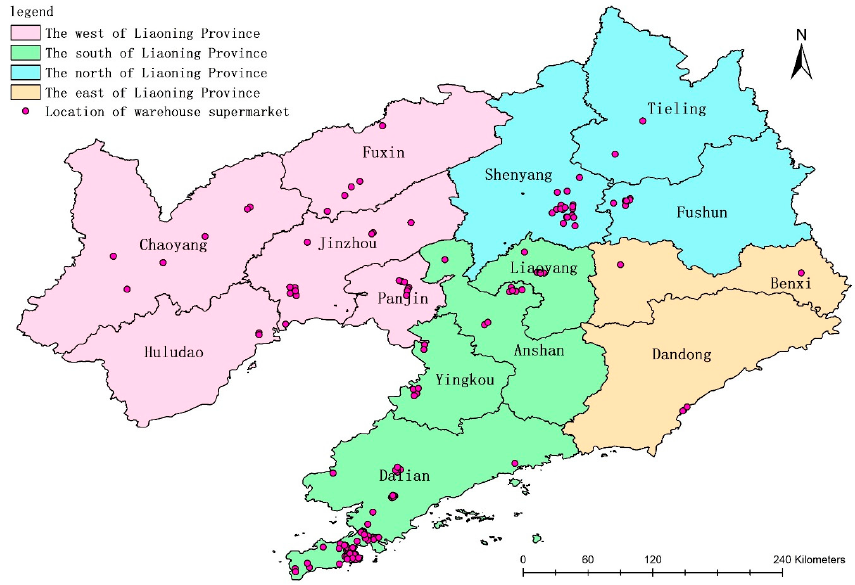
Figure 5. Location Distribution of Warehousing Supermarkets in Liaoning Province. Table 1. Statistics of Regional Proportion of Warehouse Supermarkets in Liaoning Province.